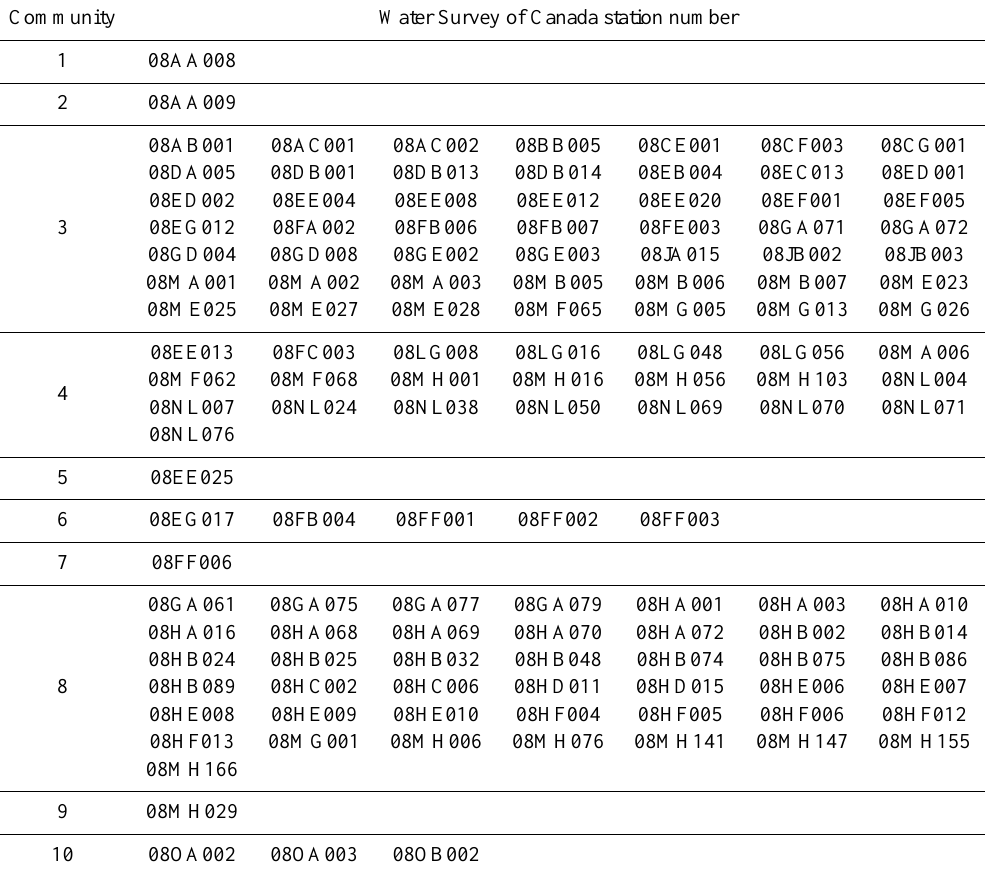
Table A1. Membership table of the communities in the streamflow network as determined by the edge betweenness algorithm.